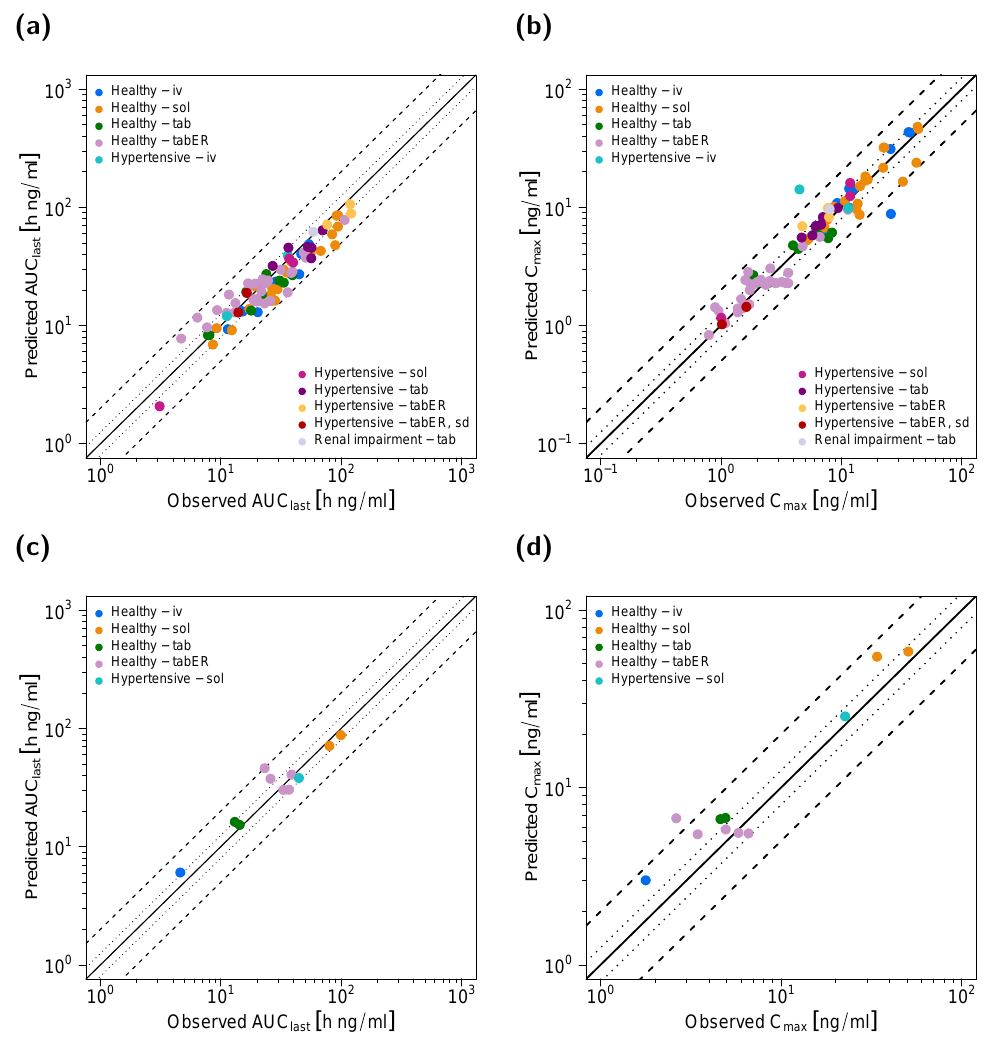
Figure 3. Performance of the felodipine PBPK model. Predicted compared to observed AUC last and C max values of ( a , b ) felodipine and ( c , d ) dehydrofelodipine stratified by route of administration and health status of the study participants. The line of identity is shown as a solid line; 1.25-fold deviation is shown as dotted lines; 2-fold deviation is shown as dashed lines. Study references are listed in Table 1. AUC last : area under the plasma concentration − time curve from the time of dosing to the time of last concentration measurement, C max : maximum plasma concentration, iv: intravenous, sol: solution, tab: tablet, tabER: extended-release tablet, sd: single